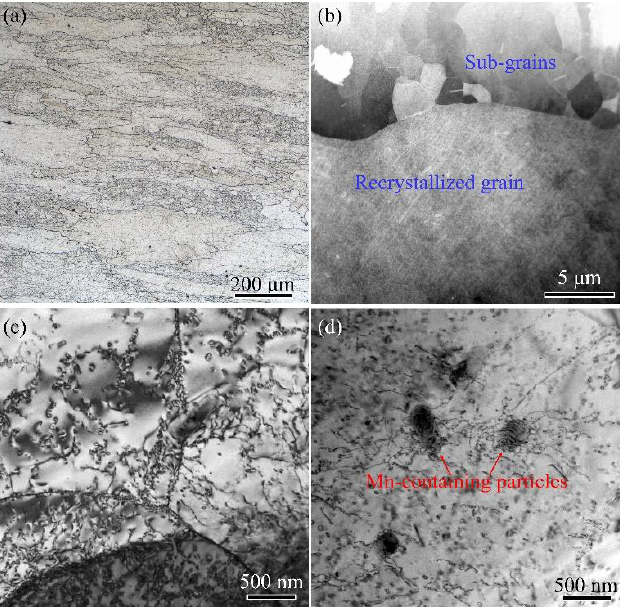
Figure 1. Metallograph and TEM images of the 2A97 Al alloy plate: ( a ) metallograph image; ( b ) TEM image; ( c ) dislocation in sub-grains; ( d ) dislocation in recrystallized grain. Samples of 10 × 10 × 10 mm 3 in dimension were cut from the 2A97 Al alloy plate.